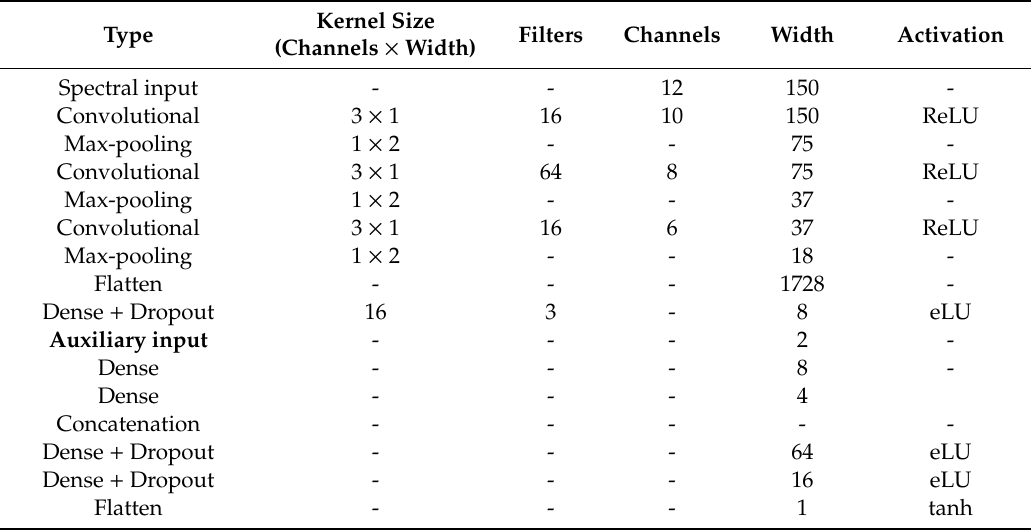
Figure 4. Convolutional neural network architecture to predict soil properties from multiple temporal observations of integrated Sentinel-1 and Sentinel-2 data. Cyan rectangles correspond to kernel filters, while the orange ones to dropout layers. The light blue represents the concatenation layers. The layers are also presented in Table 3. Table 3. Description of the layers used in the multidimensional convolutional neural network (CNN)